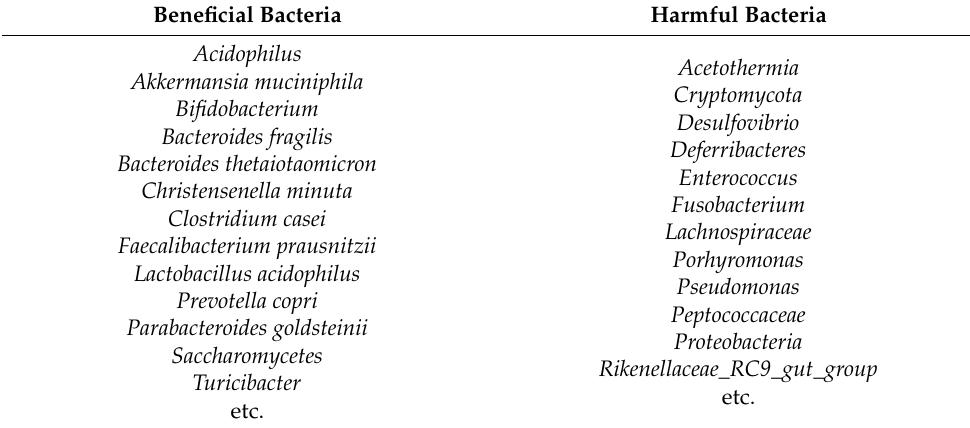
Table 3. Harmful and beneficial bacteria commonly found in